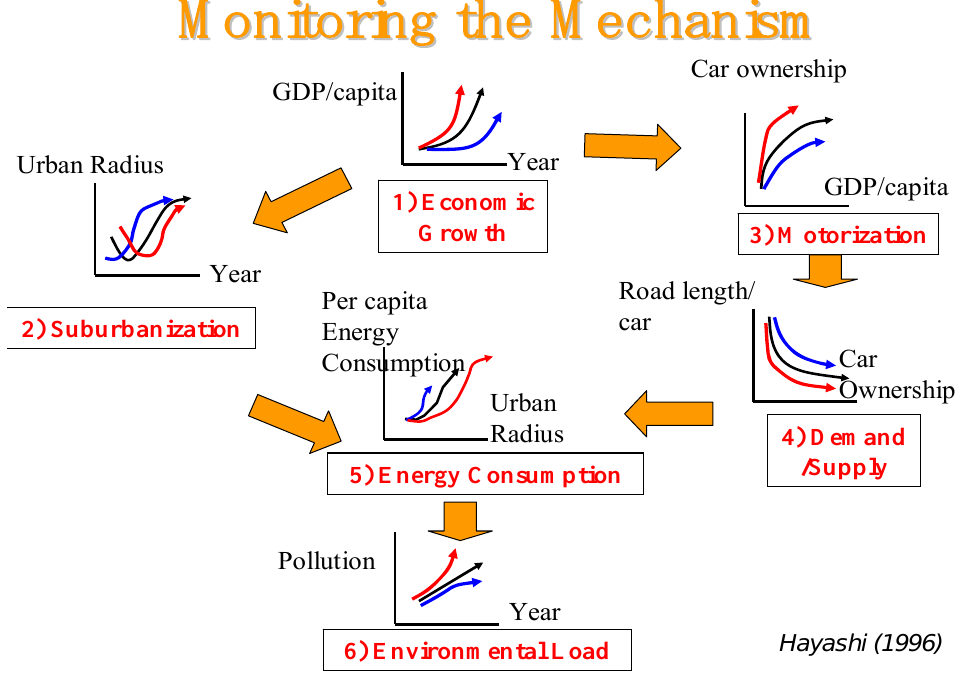
Figure 3. The Processes of Urban Development Explained with Key Mechanisms. Source: [82] M onitoring the M echanismM onitoring the M